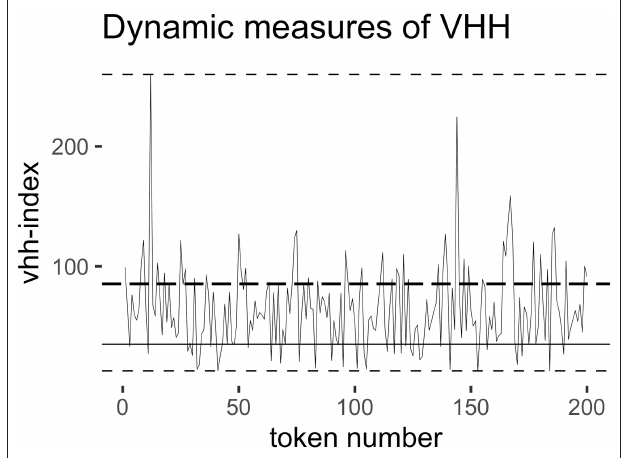
FIGURE 3 | Schematic illustration of dynamic measures of VHH. X-axis: vowel tokens in sequential order. Y-axis: vhh-index value. Horizontal solid line indicates the modal value, and thin dashed lines denote maximum and minimum, used to calculate range. Thick dashed line show the peak ratio threshold, which is calculated for IDS and ADS combined, separately for each speaker. The peak ratio is number of tokens with vhh-index exceeding this value over total number of